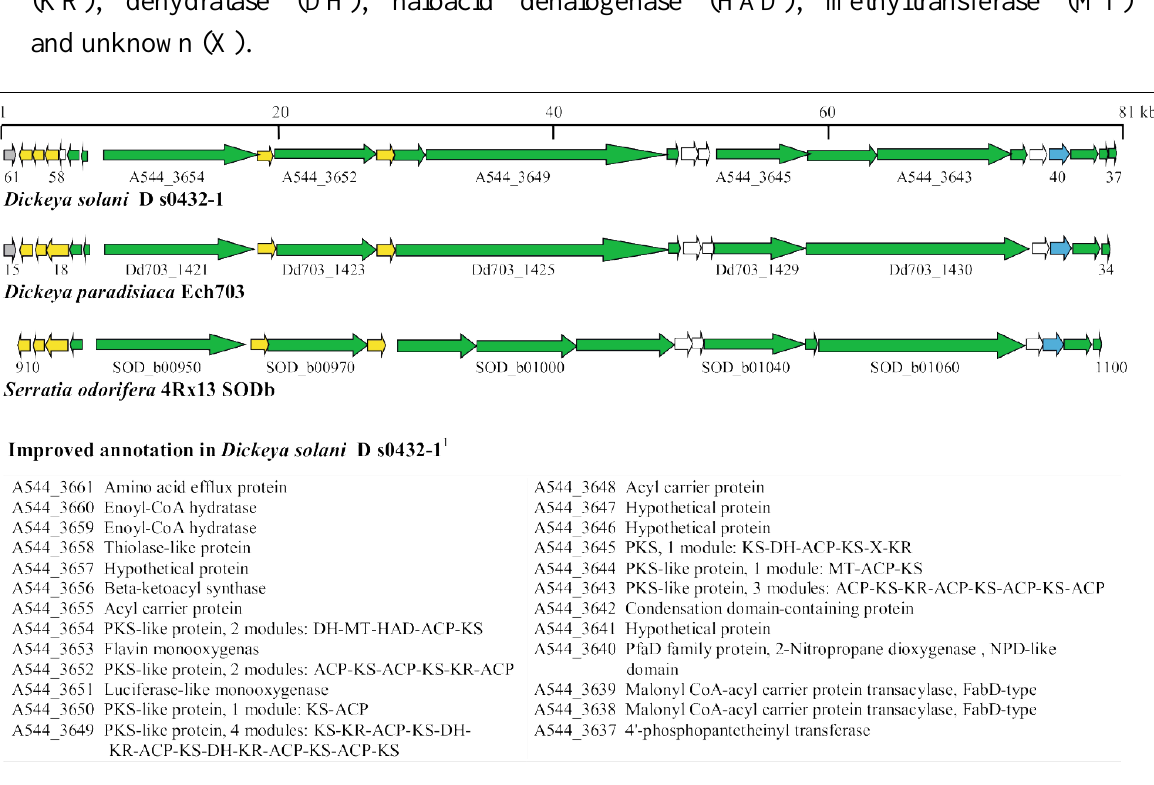
Figure 4. Alignment of the PKS cluster (genomic coordinates 4,246,194–4,327,254) of D. solani D s0432-1, with the two closest homologs in D. paradisiaca Ech703 and S. odorifera 4Rx13 SODb. The improved annotations of the genes, domains, substrate specificity conferring amino acids of the adenylation domains of NRPSs and predicted amino acids in the synthetized molecules are mentioned in the table within the figure. The colors of ORFs indicate their functions: green for PKS, blue for FAS-like, grey for transport, yellow for tailoring and white for hypothetical. For PKS, the following